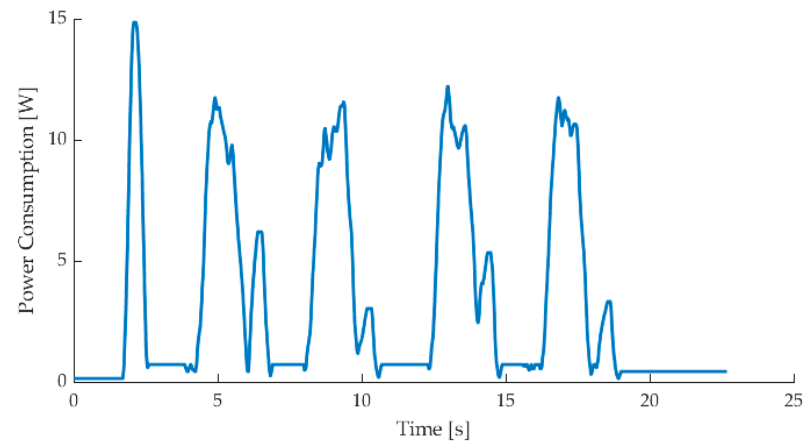
Figure 12. Power consumption acquired with a current sensor during the torso motion reported in Figures 8 and 9.